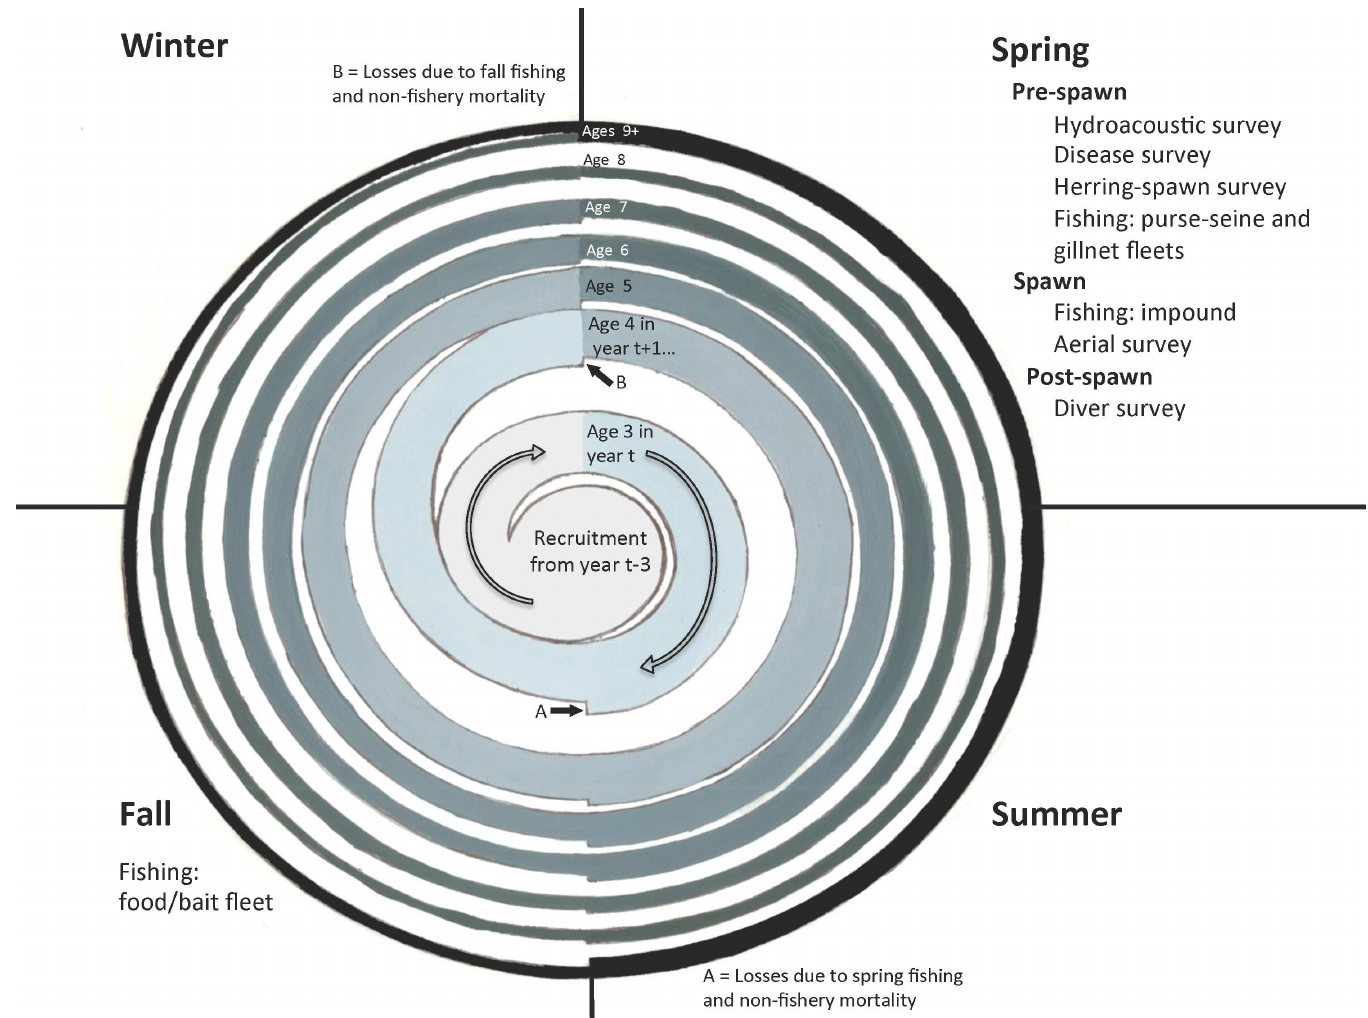
Fig 4. A schematic of the seasonal timing of fishing and sampling events included in the assessment model along with a schematic of a single cohort over seven years. Starting in the center of the spiral, the width of each separatelycolored curl representsthe relative size of the cohort at a certain age and lighter colors denote youngerages of the cohort in earlier years. The cohort is reducedby fishery and non-fishery mortality effects (in that order) after the first 6 months (event A) and the last 6 months (event B) of every year before becominga year older. The plus group is representedas a completecircle with two inputs: herringof age 8 and herringalready in the plus